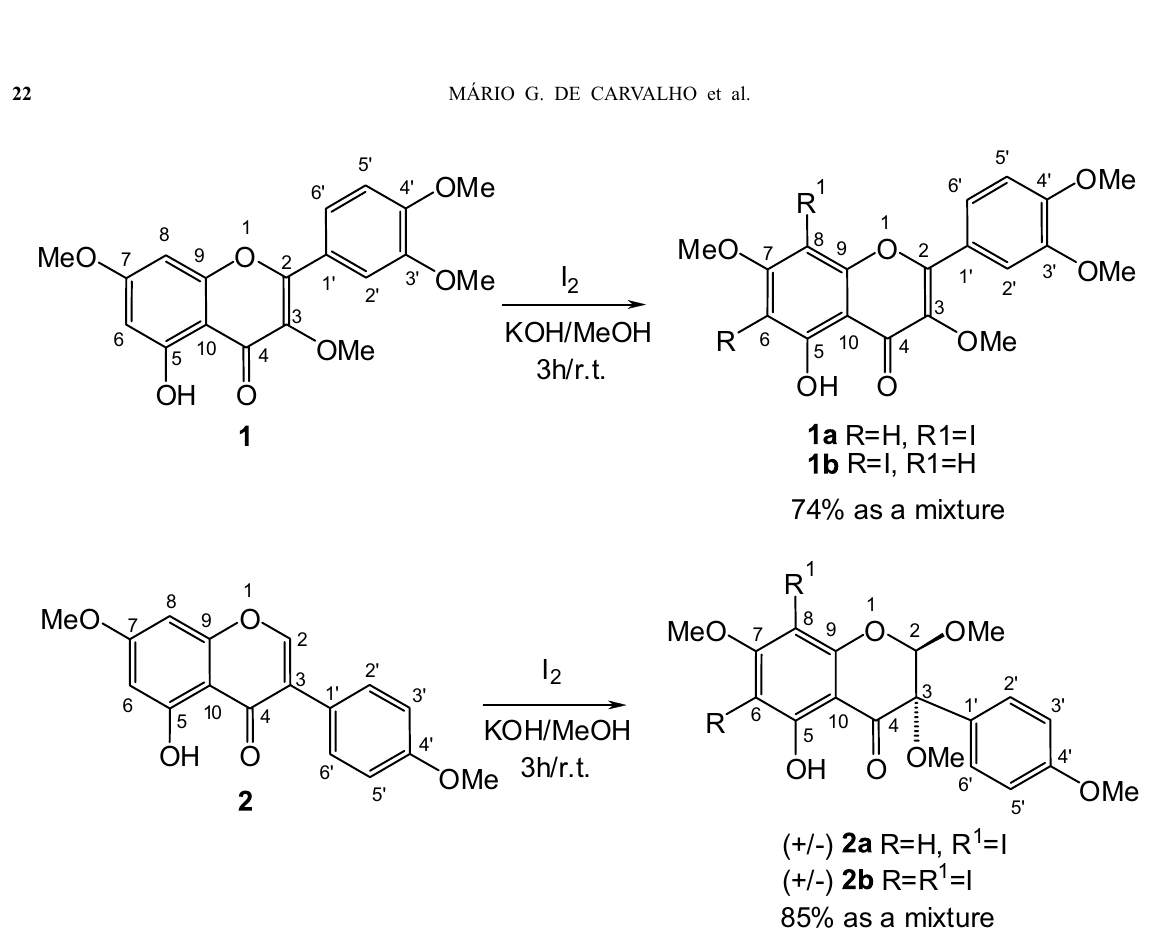
Fig. 1 – Structure and reactions of flavonoids 1 and 2